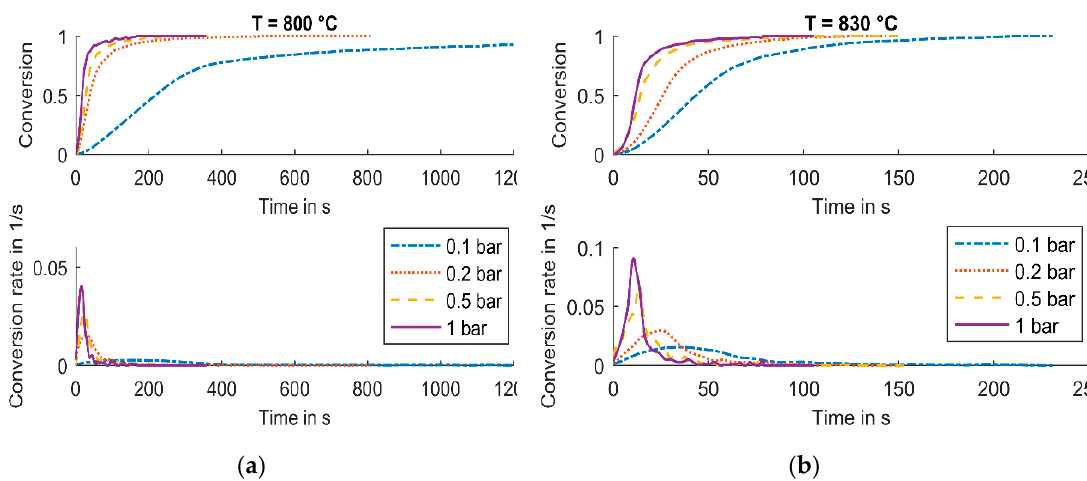
Figure 8. Influence of different oxygen partial pressures on reactions and reaction rates at two temperatures, 800 °C and 830 °C. Please note the different time axes for 800 °C ( a ) and 830 °C ( b ).